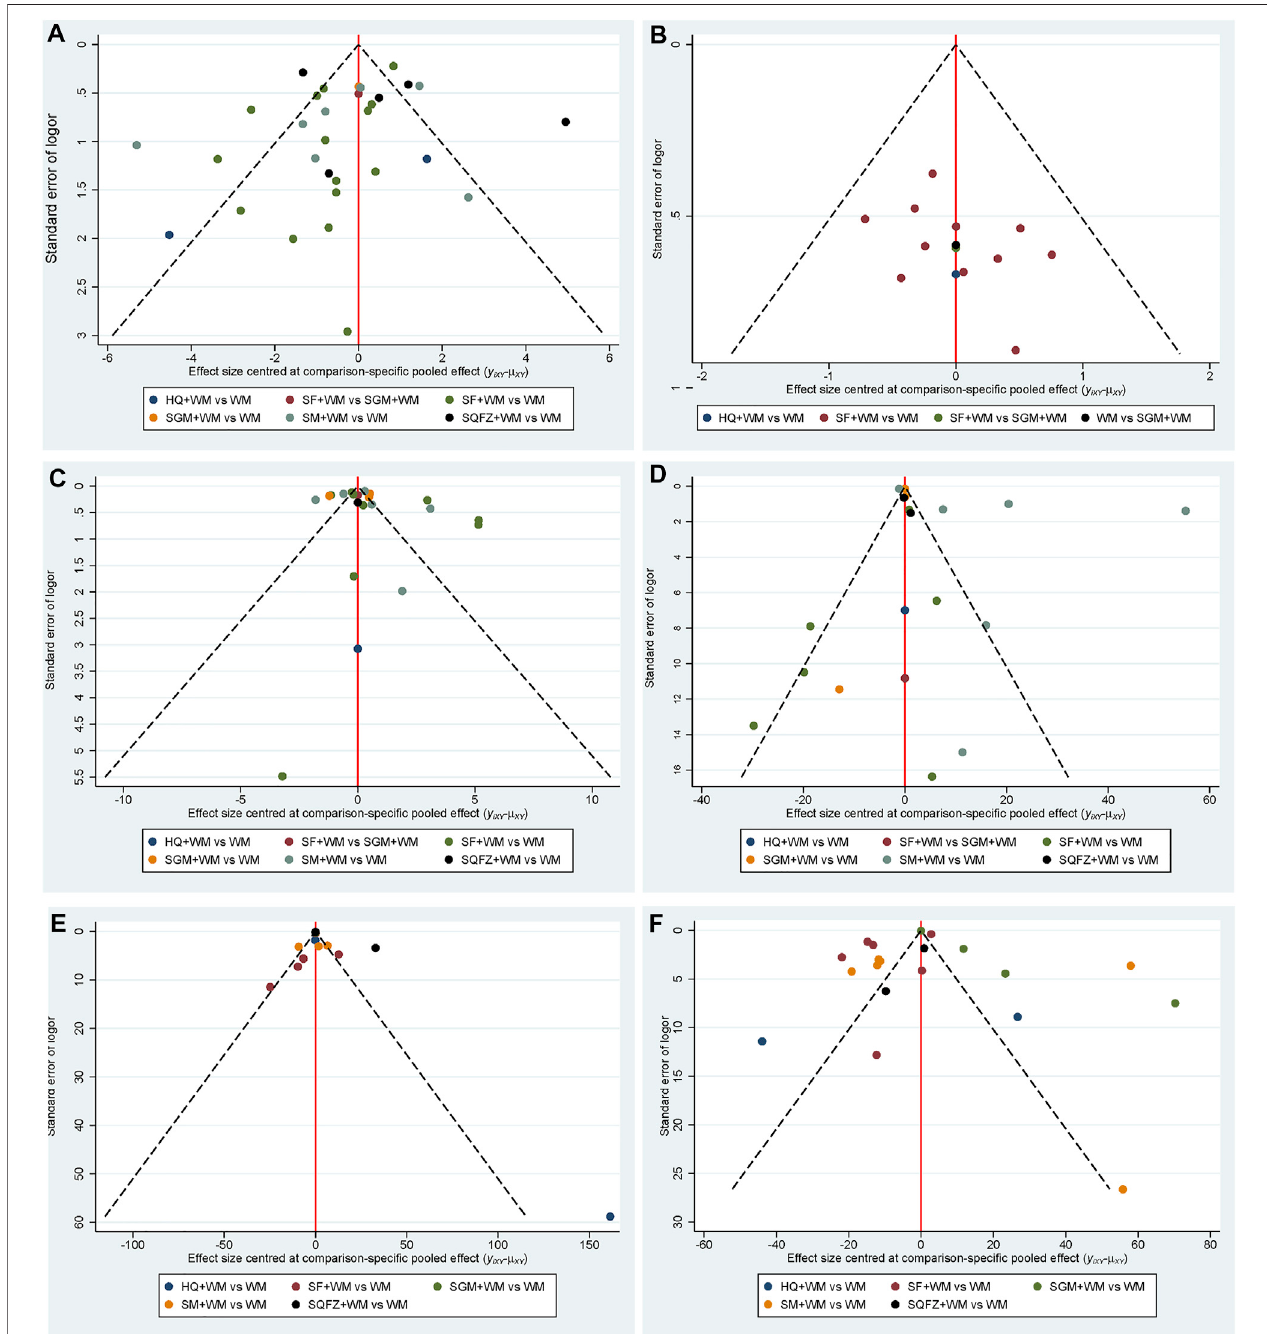
FIGURE 5 | Funnel Plot. Note: (A) : APACHE II score; (B) : 28-days mortality; (C) : PCT; (D) : CRP; (E) : IL-6; (F) : TNF- α ; (G) : CD4 + ; (H) : CD8 + ; (I) : CD4 + /CD8 + .